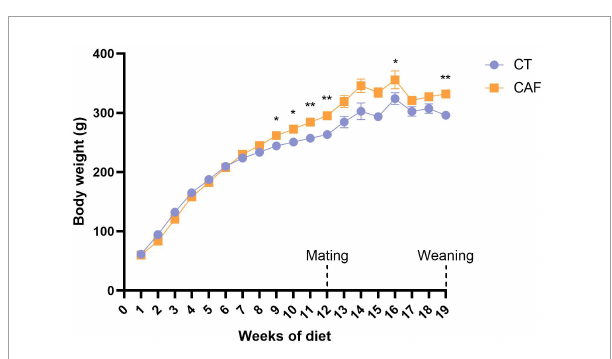
TTCTCTACC; TNF α : R: CCCGCAATCCAGGCCACTACTT;